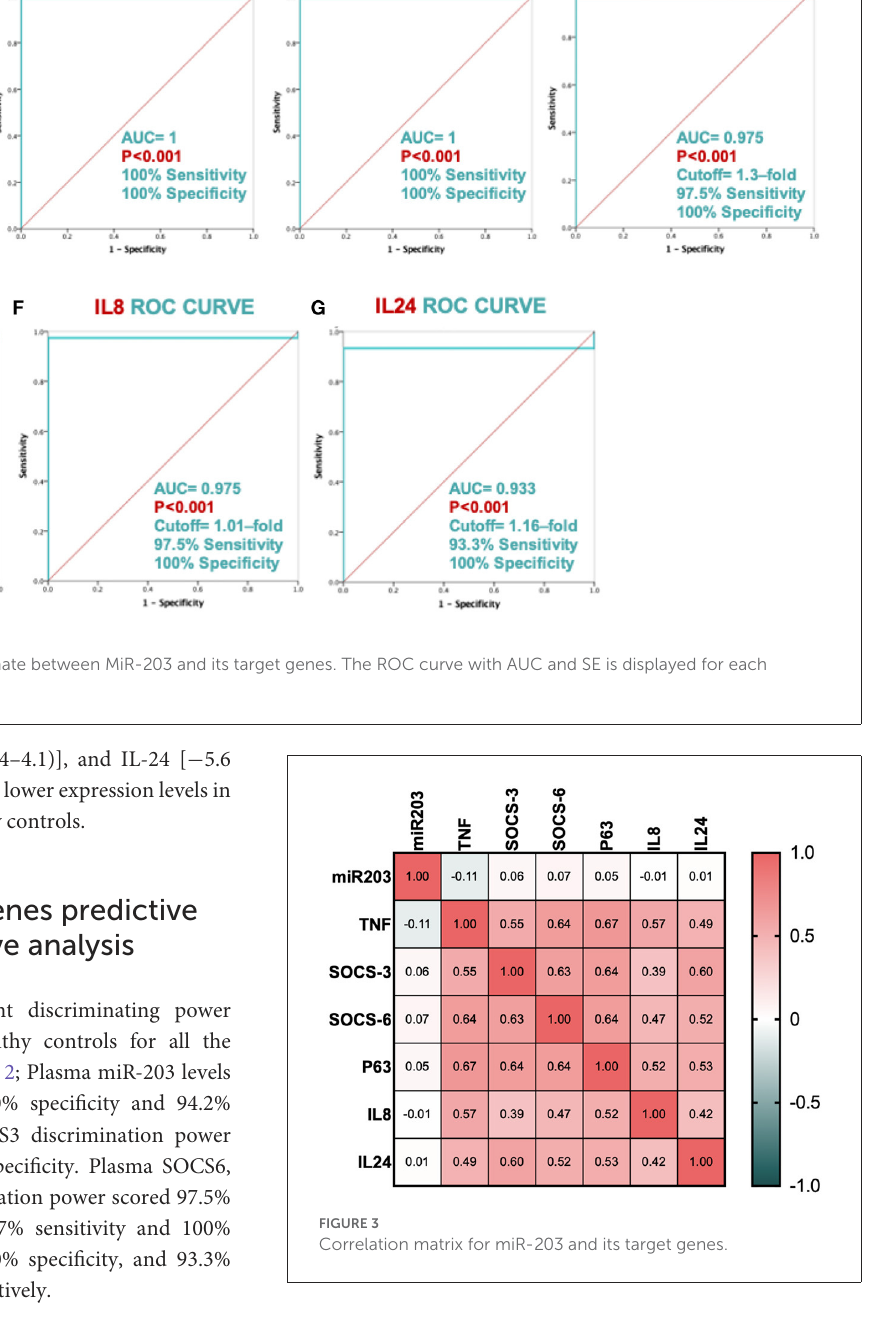
FIGURE3 Correlation matrix for miR-203 and its target